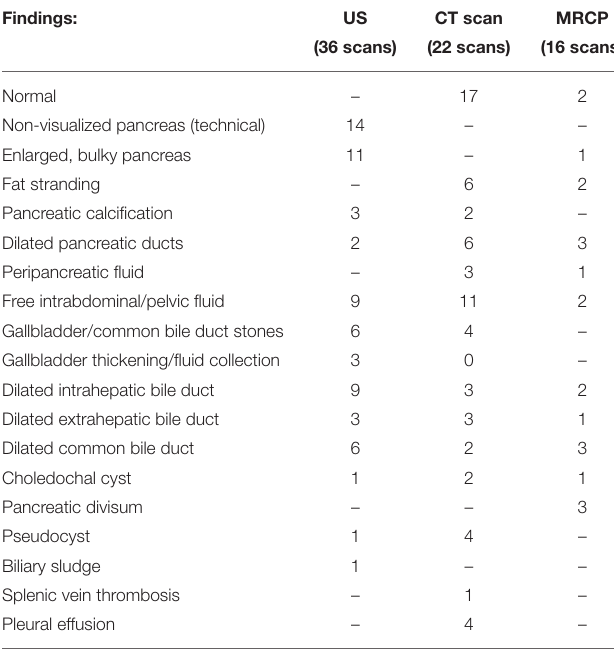
TABLE 5 | Radiologic findings using various imaging modalities.